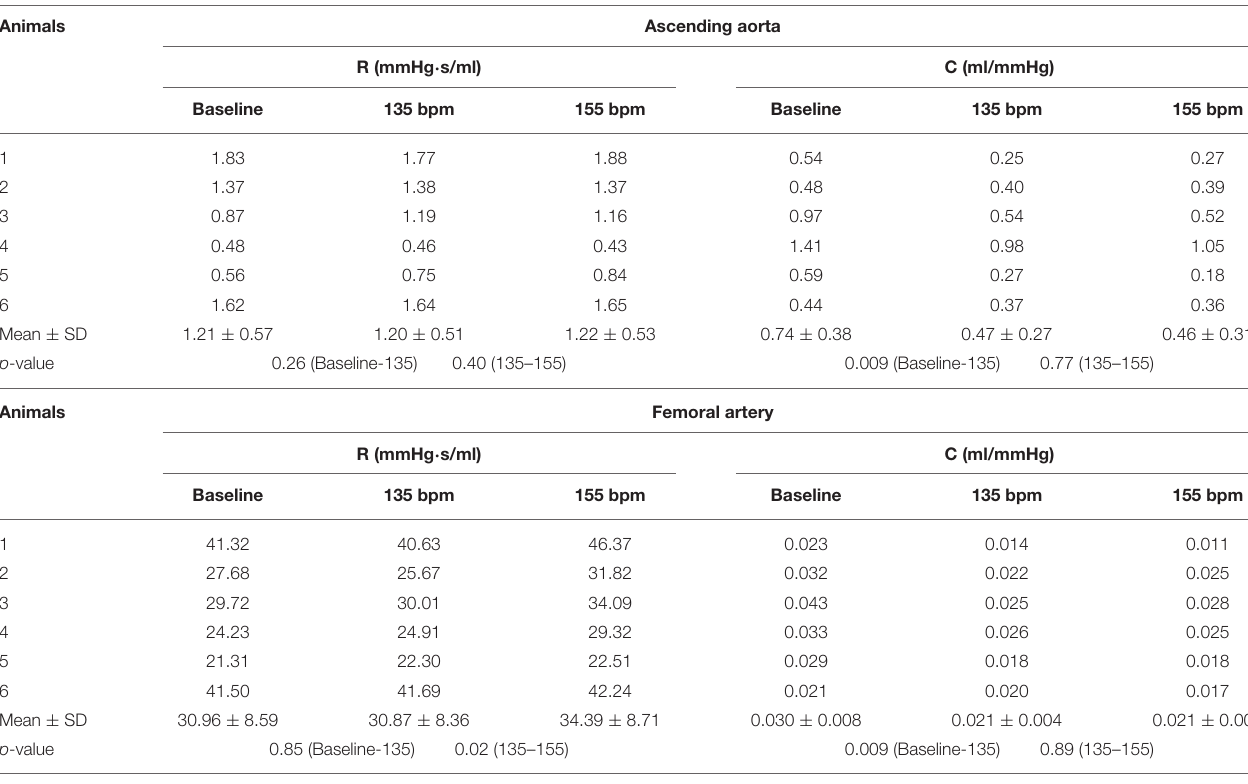
TABLE 1 | Hemodynamic parameters in ascending aorta and femoral artery at baseline (80–105 bpm) and HR of 135 and 155 bpm.